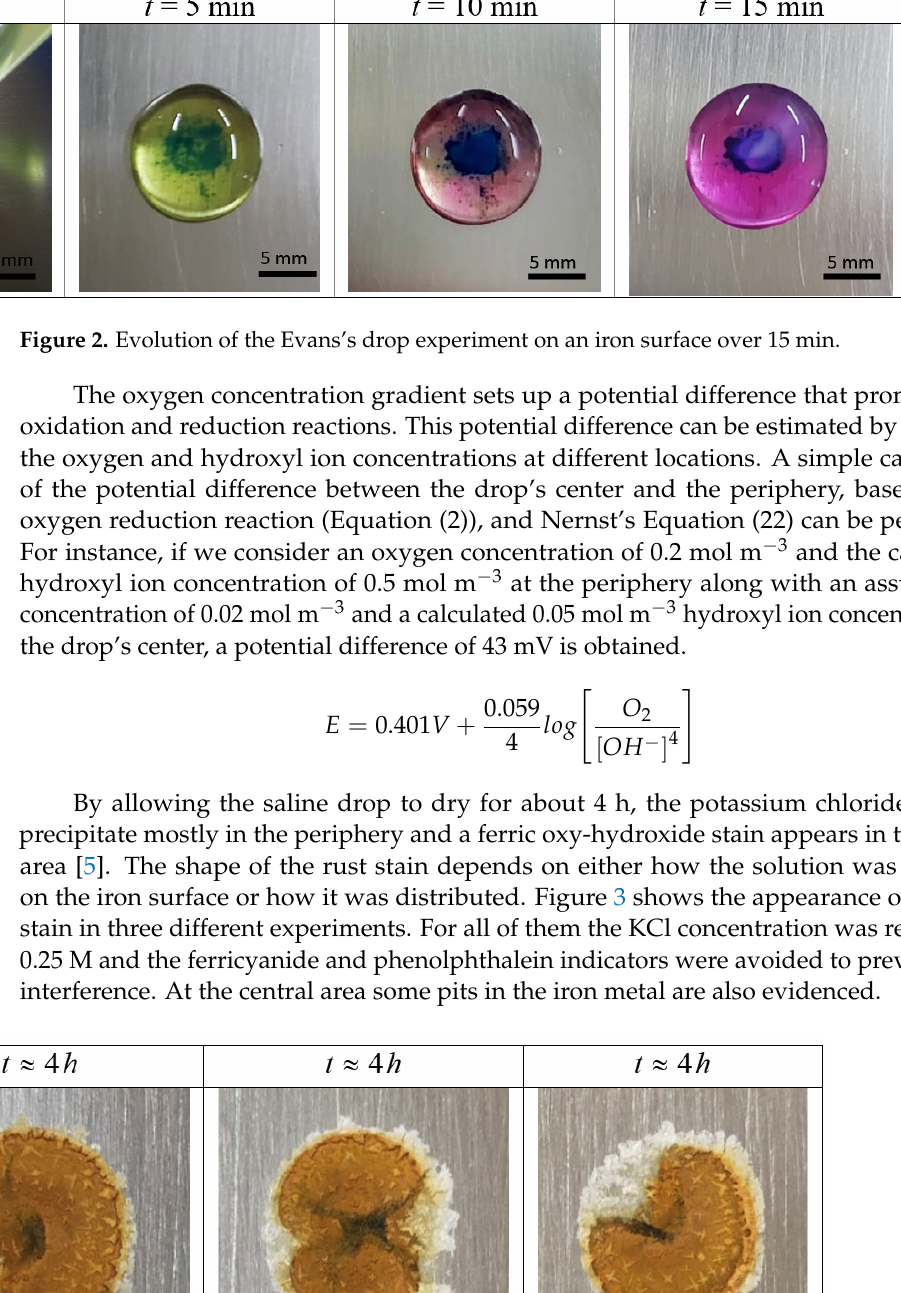
Figure 3. Oxide stain and salt crystals in a dried Evan’s drop experiment after 4 h at room tempera- ture.